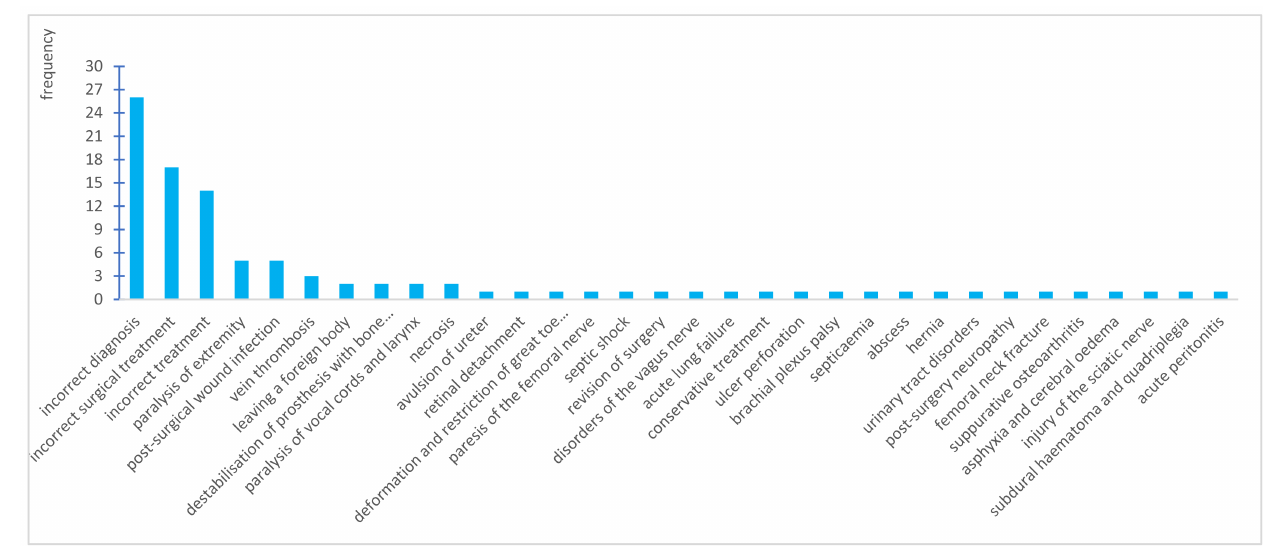
Figure 4. Type and amount of adverse events which form the basis for the claim.